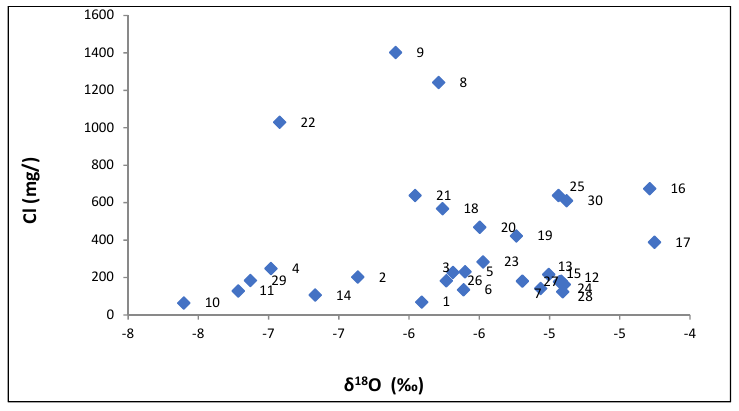
Figure 15. Plot of the levels δ 18 O versus the concentration of Cl − .